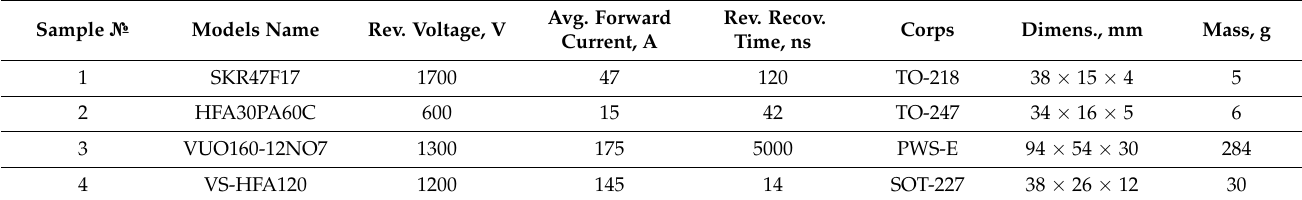
Table 2. Characteristics of the studied